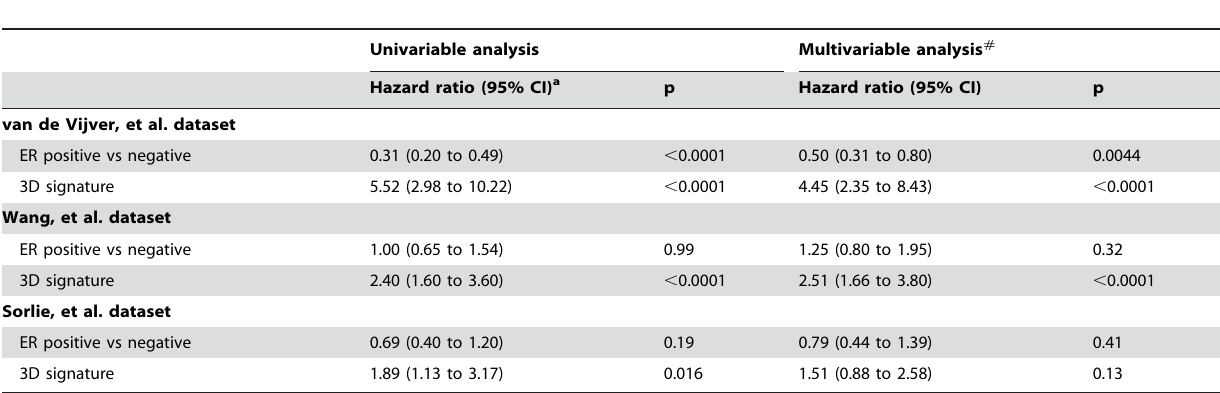
Table 3. Univariable and multivariable proportional-hazards analysis of survival risk for three large independent testing sets*.